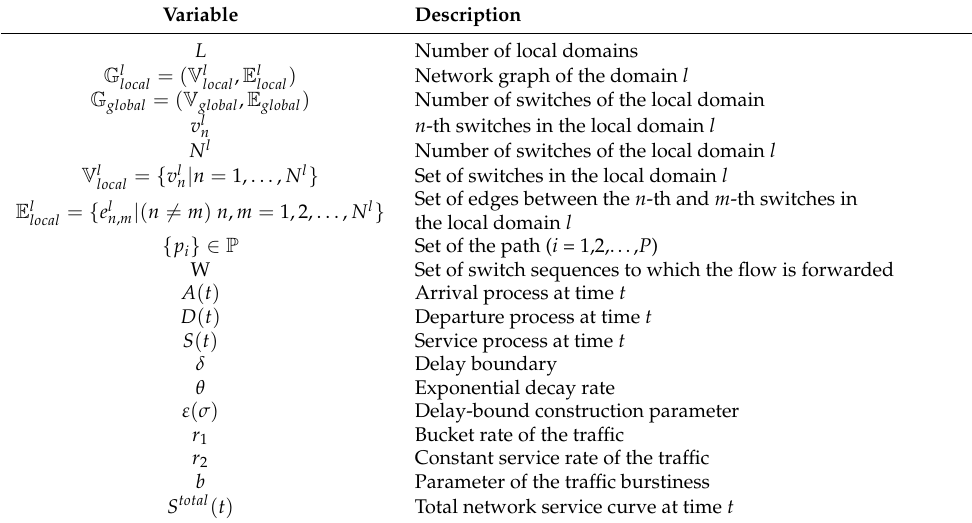
Table 2. Detailed meanings of major symbols